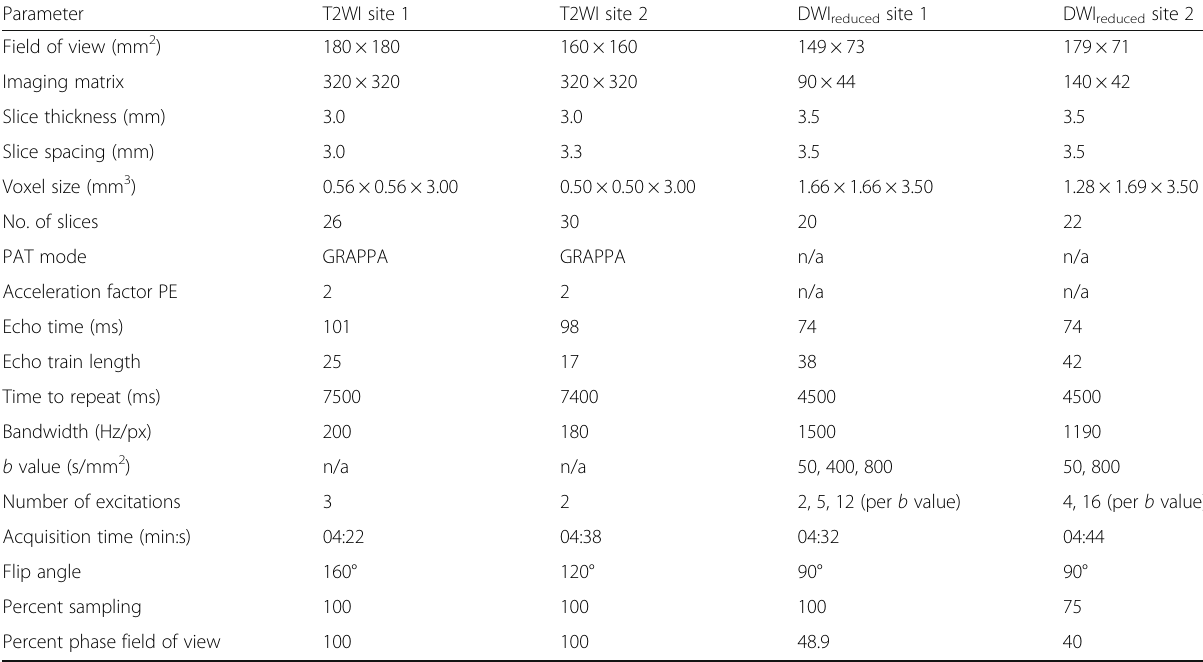
Table 1 Magnetic resonance sequences and parameters for axial imaging in kiwifruits and human prostates at two different institutions (site 1, site